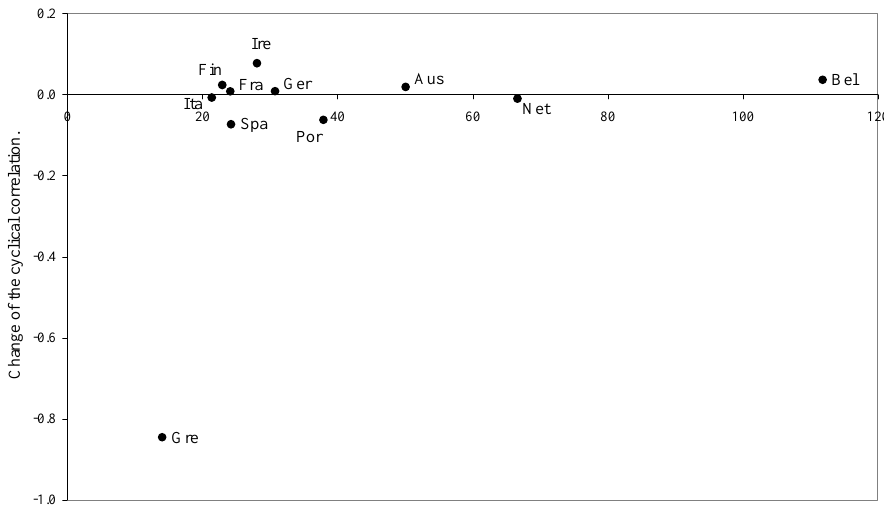
Figure 6.- Change in the bivariate cyclical correlation between 2011:4 and 2007:3 against trade intensity with the euro area for 2007